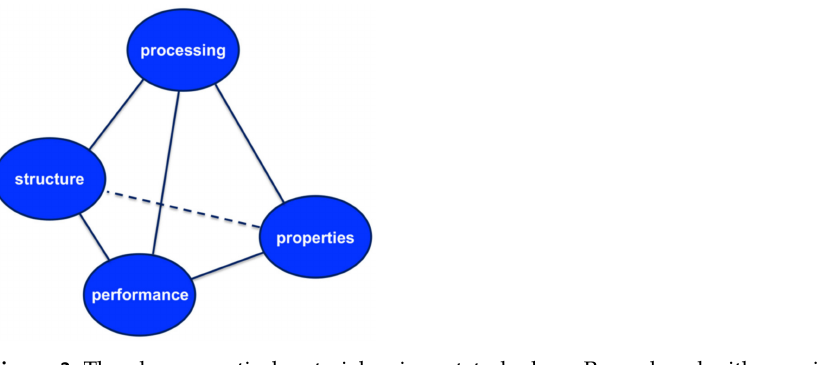
Figure 3. The pharmaceutical materials science tetrahedron. Reproduced with permission from [40], Elsevier,